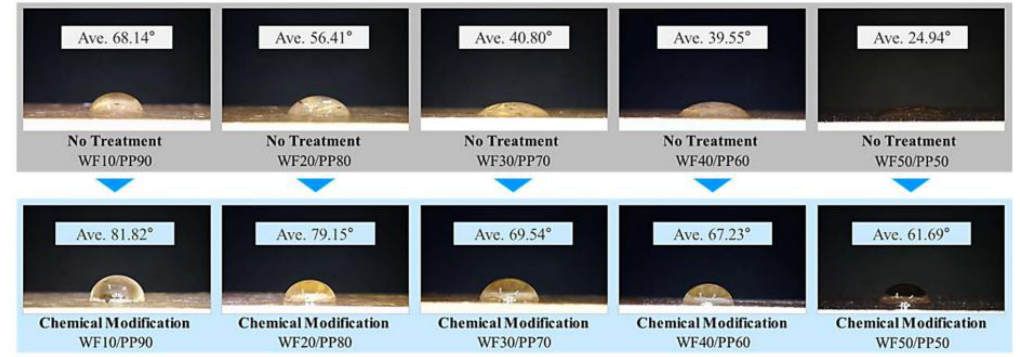
Figure 13. The contact angle measurements of chemically modified and untreated wood-plastic composite injection-molded ASTM specimens.